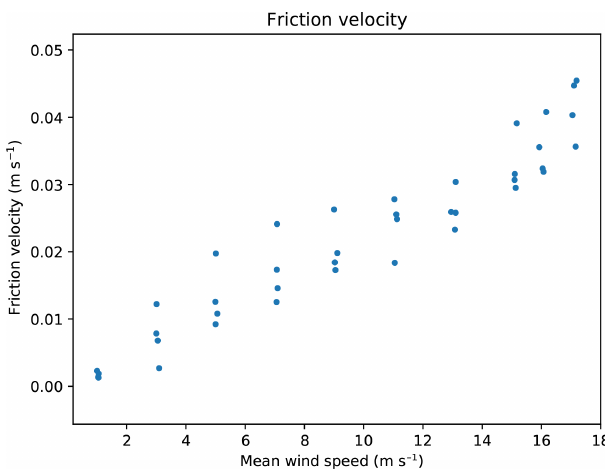
Figure C1. Friction velocity (ms − 1 ) in the wind tunnel during the AHFO